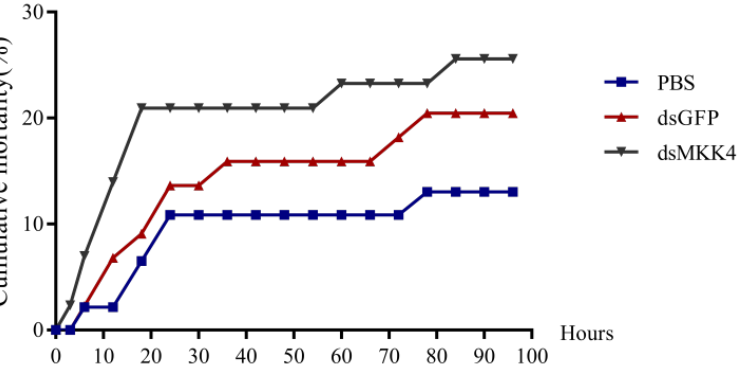
Figure 8. Mortality changes of Penaeus monodon in different gene silencing groups under acute low salinity stress.